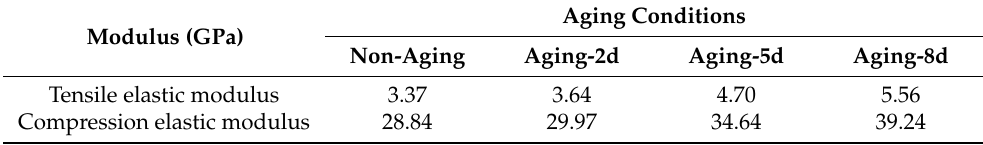
Table 5. The calculated results of Pb_emod and emod. Parameters